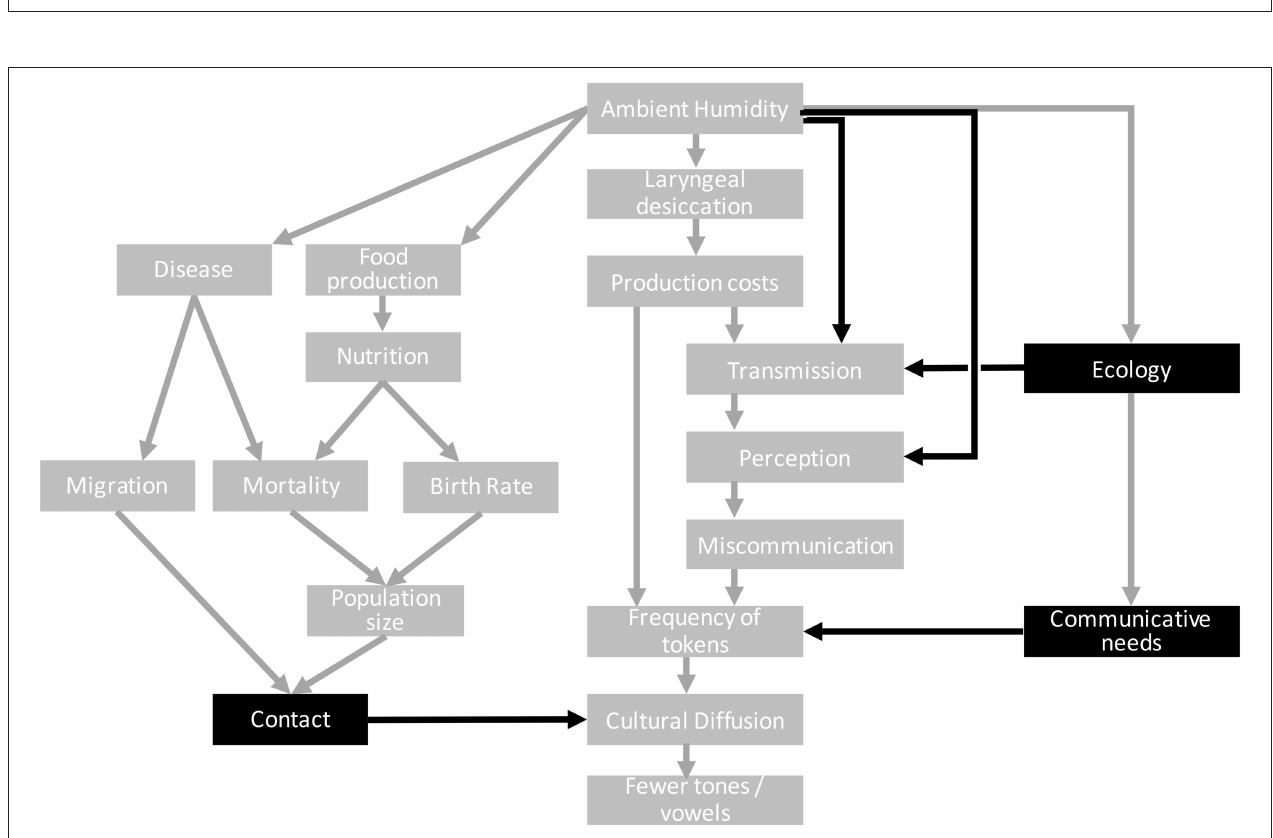
FIGURE 2 | Steps 4 and 5 of the causal approach. Additional nodes represent the wider causal context. Nodes and arrows in black indicate potential confounds that need to be addressed.